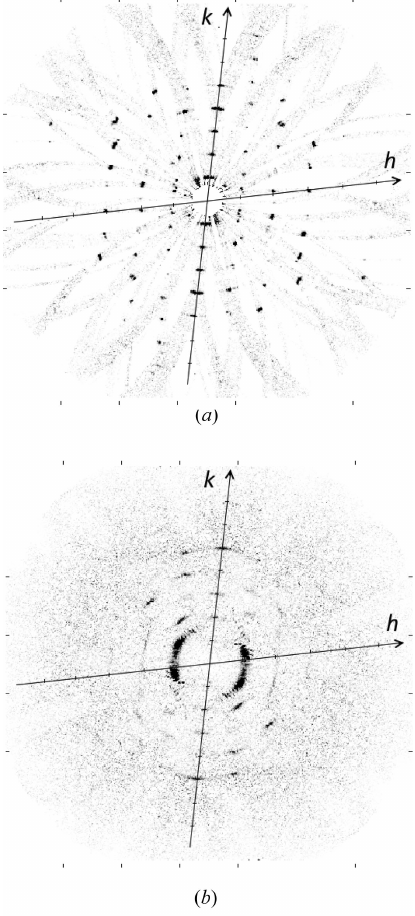
Figure 11 Three-dimensional merge of the diffraction data, ( a ) on the equatorial ( l = 0) plane and ( b ) on the first ( l = 1) layer plane, as described in the text.